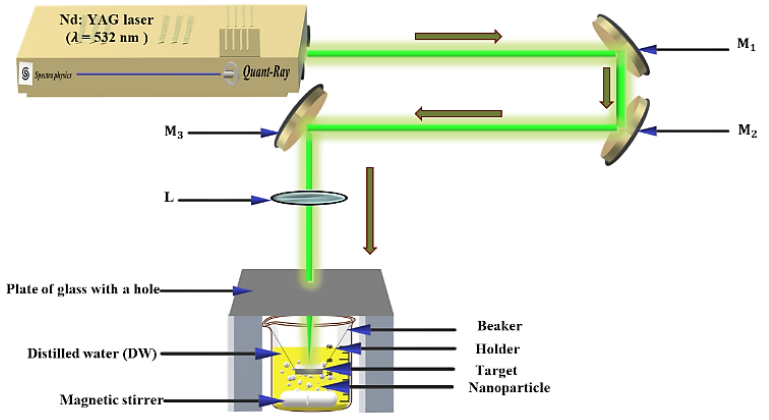
Figure 1. The experimental setup of the laser ablation method for the synthesis of the Au NPs using a nanosecond Nd: YAG Laser.